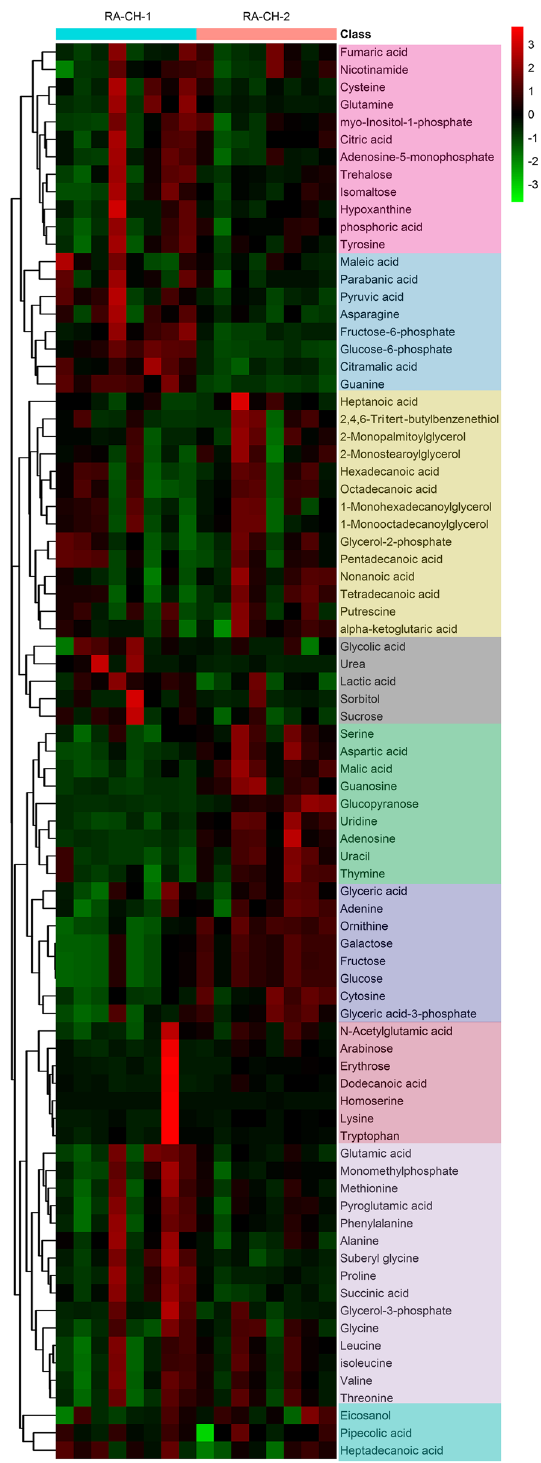
Figure 3. Heatmap of total metabolites in RA-CH-1 and RA-CH-2. Colors represent fold-change values between each line and the samples. Red squares in the heat map indicate increases of intracellular metabolite concentration, while green squares indicate decreases of intracellular metabolite concentration. Fold-change values were log2-transformed. Both columns (samples) and rows (metabolites) were subjected to hierarchical clustering analysis